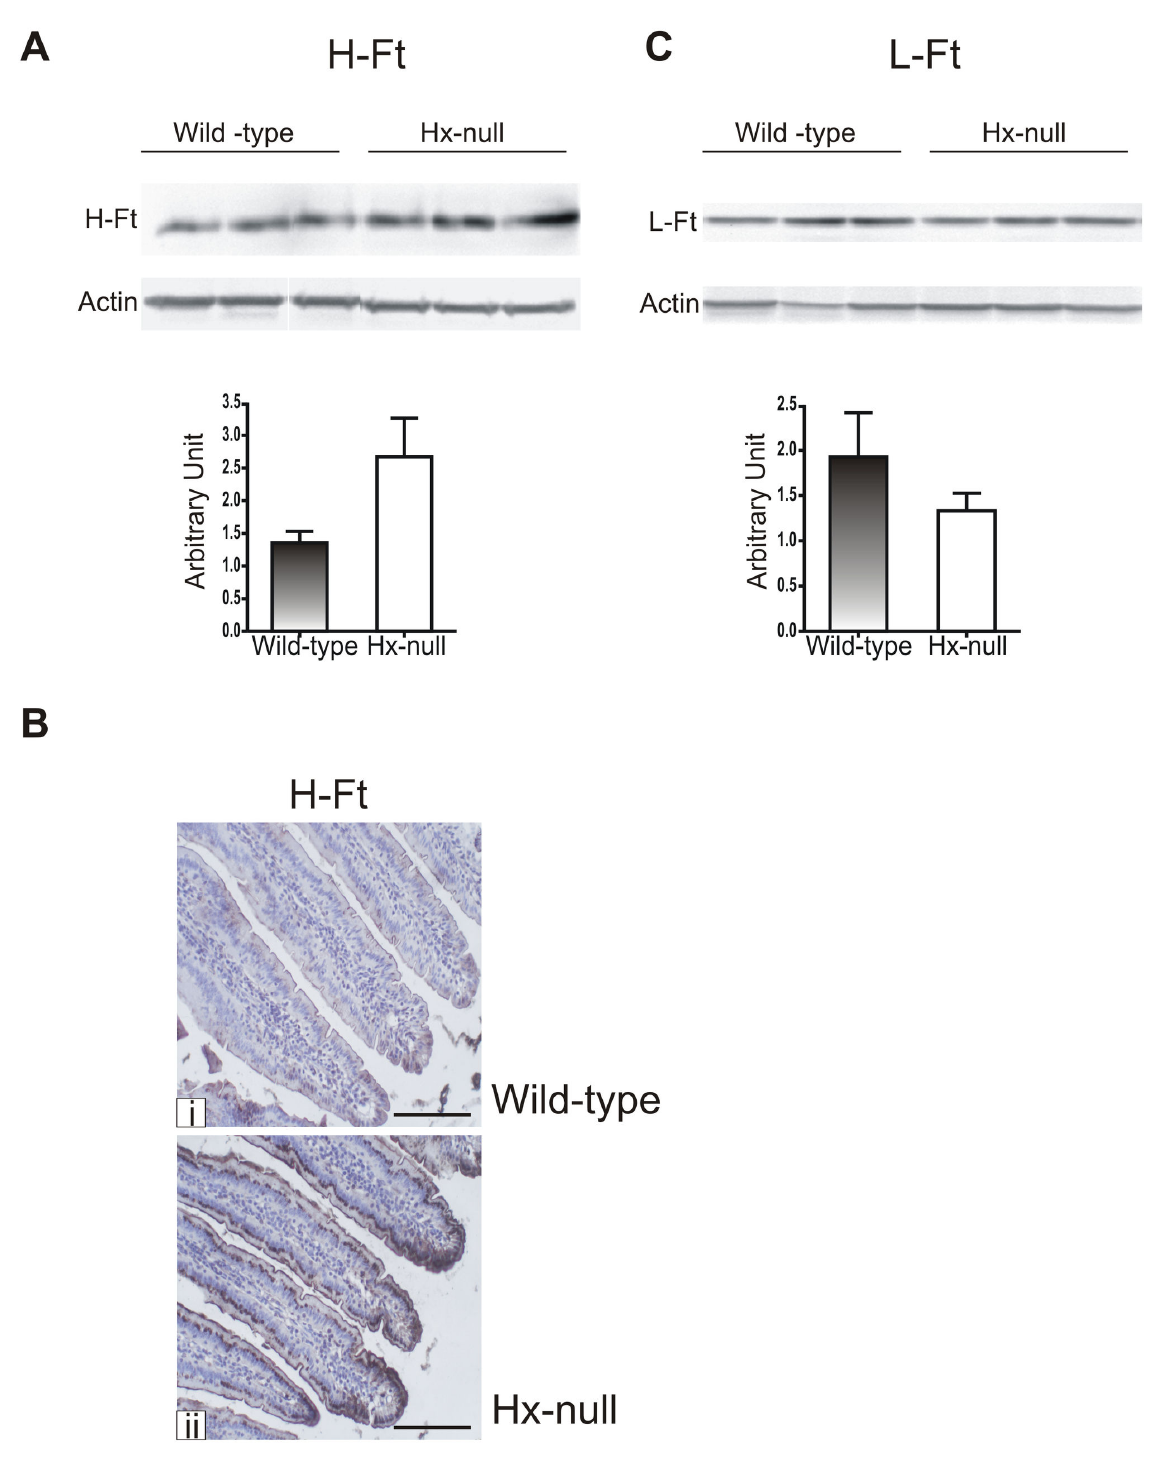
Figure 2. Increased H-Ft expression in Hx-null mice duodenum. Representative Western blots of H-Ft (A) and L-Ft (C) expression in the duodenum of wild-type and Hx-null mice. Band intensities were measured by densitometry and normalized to actin expression. Densitometry data represent mean ± SEM; n=3 for each genotype. (B) Duodenal sections of a wild-type mouse (i) and an Hx-null mouse (ii) processed by immunohistochemistry with an anti-H-Ft antibody. The H-Ft-positive signal is increased in the duodenum of the Hx-null animal. Bar= 100µm. doi: 10.1371/journal.pone.0068146.g002 PLOS ONE |